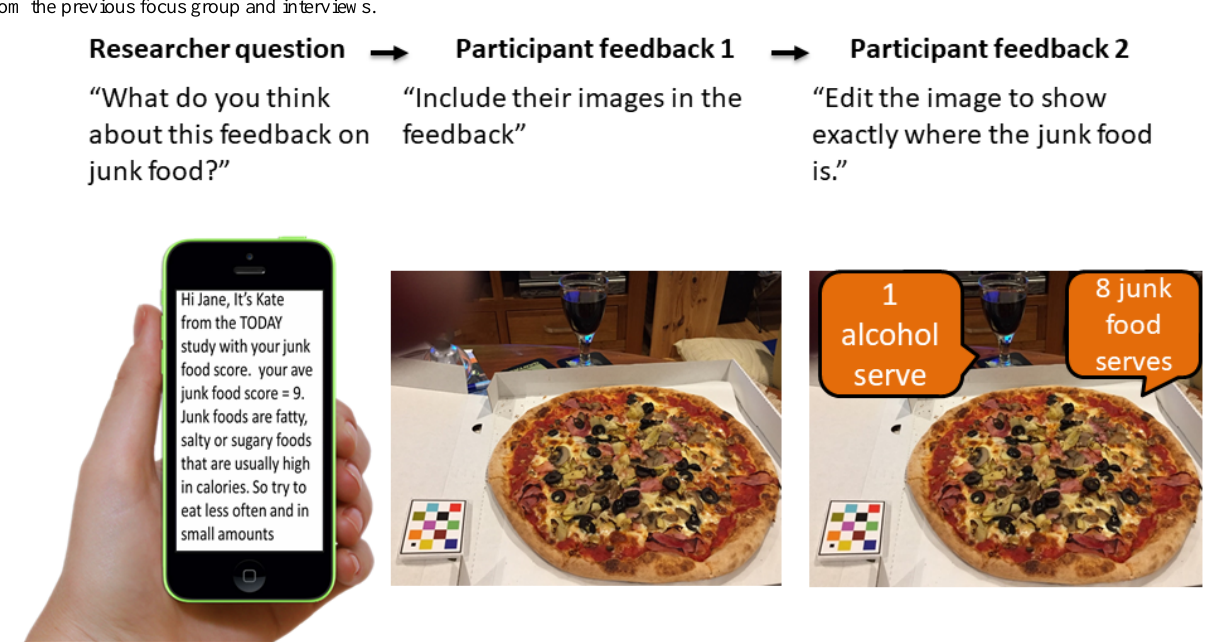
Figure 3. Example images showing how new ideas on how to provide dietary feedback were incorporated using an iterative process based on feedback from the previous focus group and